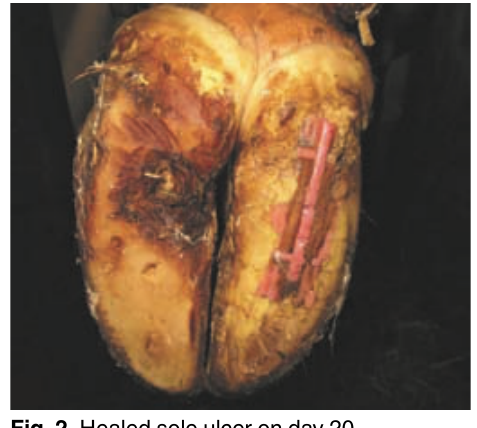
Fig. 2. Healed sole ulcer on day